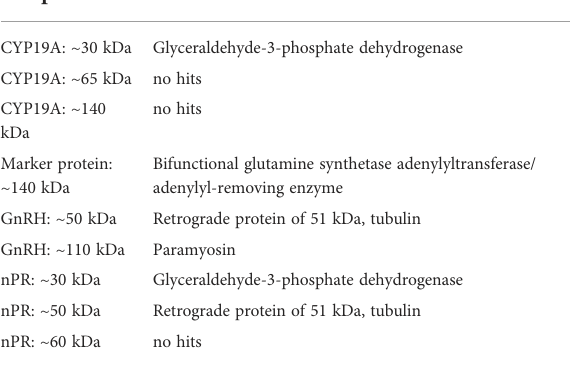
TABLE 4 List of the identi fi ed proteins corresponding to excised bands from PAGE by LC-MS analysis. Sample